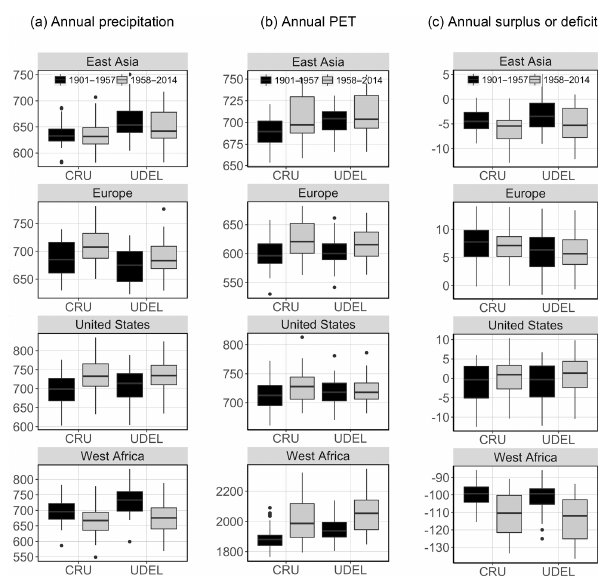
Figure 3. Temporal variations in annual precipitation (mm), poten- tial evapotranspiration (PET; mm) and surplus or deficit ( D ; mm) based on two datasets (CRU and UDEL) and periods (1901–1957 and 1958–2014). In the box plots, the center line represents the me- dian value; the bottom and top of each box represent the 25th and 75th percentiles of the data, respectively; and the dots represent out-